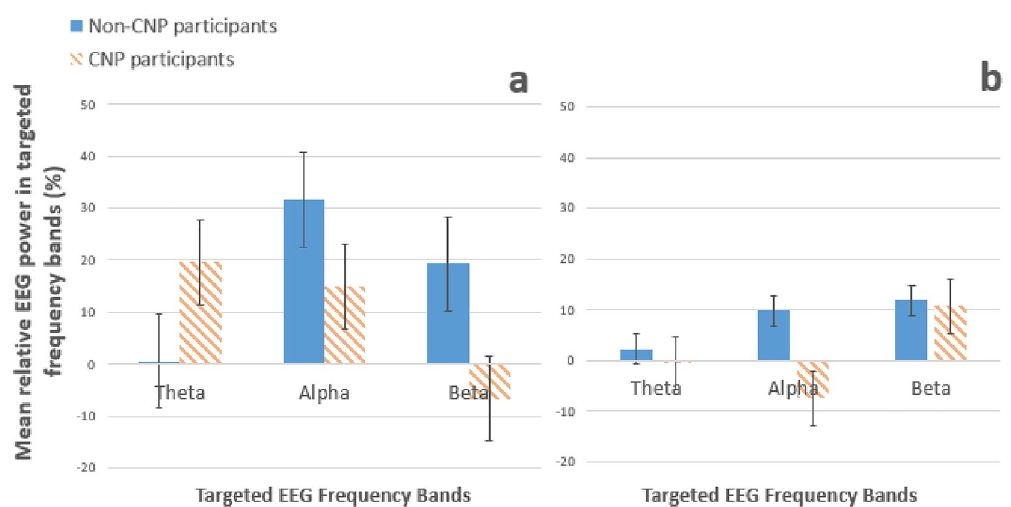
Figure 4. Comparisons between non-CNP participants and CNP participants categorised by ( a ) successful and ( b ) unsuccessful participants for each frequency band (theta, alpha, and